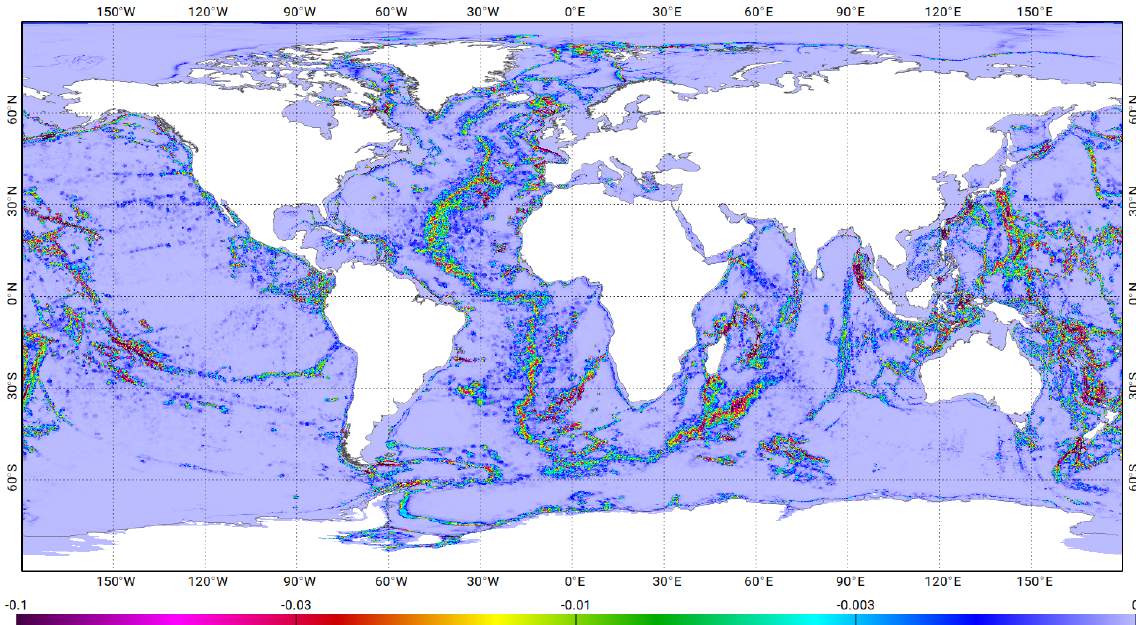
Figure 20. M2 barotropic energy conversion rate (Wm − 2 ) toward baroclinic internal tides computed from FES2014 hydrodynamic